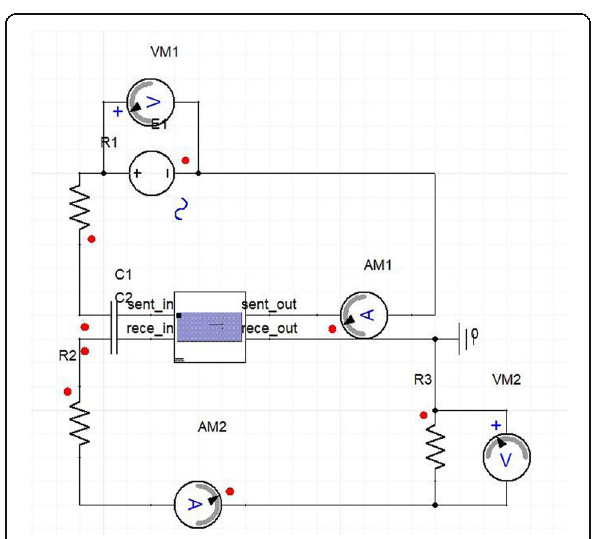
Fig. 10 Circuit simulation diagram on